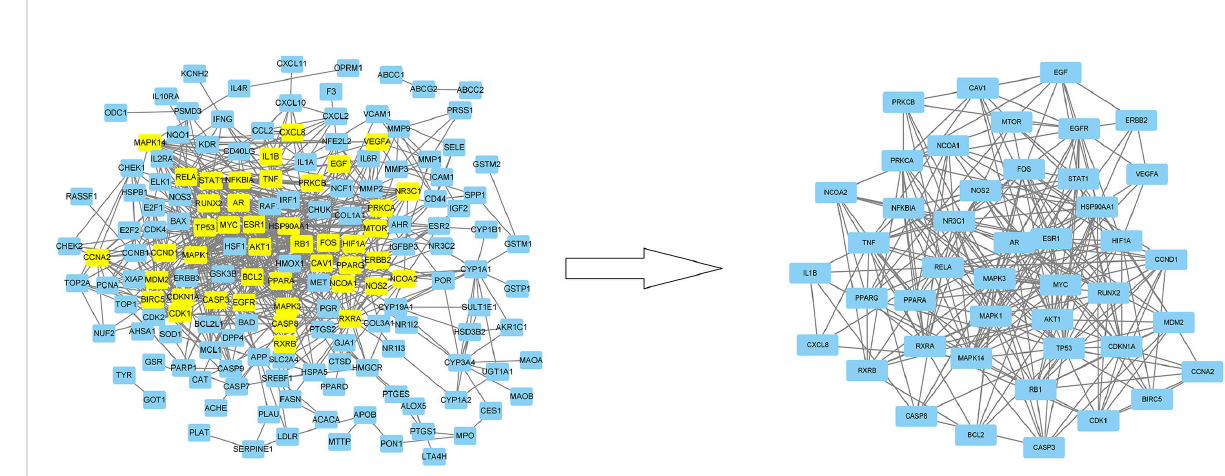
FIGURE 7 The protein-protein interaction (PPI) network. The PPI network contains 165 nodes and 729 edges. The areas highlighted in yellow are represented the candidate targets ranked in the median values for the DC, BC, CC, EC, LAC, and NC. The PPI network for the candidate targets ranked in the median values for the DC, BC, CC, EC, LAC, and NC. The PPI network contains 44 nodes and 429 edges. The areas highlighted in yellow are represented the potential targets with the median values for the DC, BC, CC, EC, LAC, and NC.